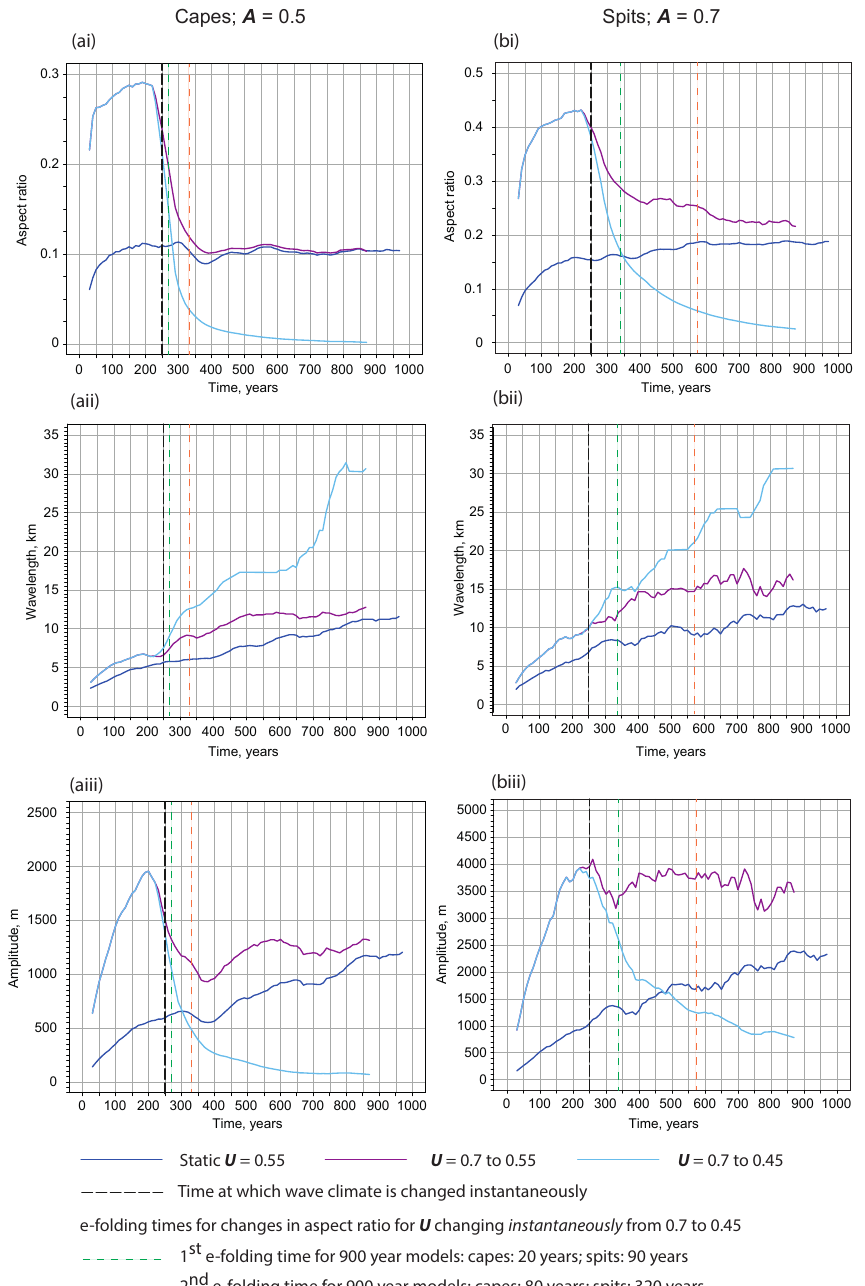
Figure 5. Time series of the evolution of aspect ratio (amplitude / wavelength), wavelength and amplitude for (ai–iii) capes and (bi–iii) spits under instantaneous change in wave climate at 250 years (900-year models). In all panels, dark blue line: the results for the coastline evolved under a static wave climate with U = 0 . 55 for both spits and capes; light blue line: U changing from 0.7 to 0.45; and purple line: U changing from 0.7 to 0.55. The e -folding times are shown graphically for the 900-year models. These relate specifically to change from U = 0 . 7 to U = 0 . 45, based on change in aspect ratio. See text and Supplement. Note: data are smoothed by a seven-point moving average to aid clarity; see Fig.